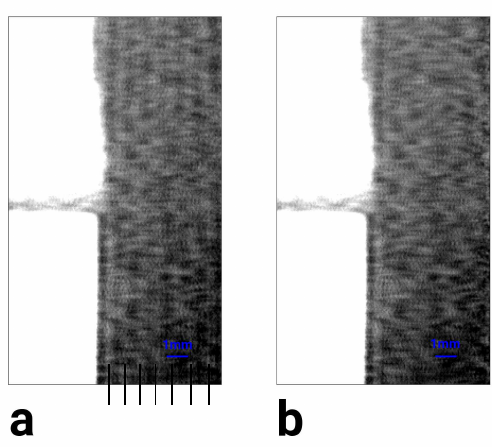
Figure 6. Attenuation images, reconstructed with a FT filter applied to the whole moiré image ( a ) and the sliding window reconstruction ( b ). Only the sponge ( top ) and the step-wedge ( bottom ) are shown. On the right of the one-step reconstruction, a moiré pattern is still visible ( a ). The fringes of the moiré pattern are marked by the black lines on the bottom of the image. These artifacts can be reduced strongly by performing the windowed reconstruction ( b ). The images correspond to the green area in Figure